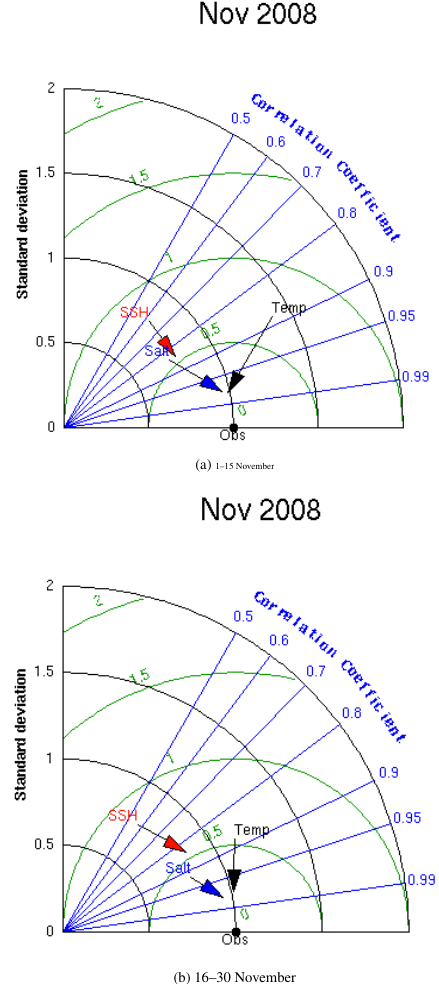
Fig. 4. Taylor Diagram for the two 15 day assimilation fits. (a) For Fig. 4: Taylor Diagram for the two 15 day assimilation fits. (a) For the first 15 day fit for 1–15 the first 15 day fit for 1–15 November 2008. (b) For the second 15 November 2008. (b) For the second 15 day fit for 16–30 November 2008 for salinity (blue arrow), day fit for 16–30 November 2008 for salinity (blue arrow), SSH (red SSH (red arrow) and temperature (black arrow). arrow) and temperature (black